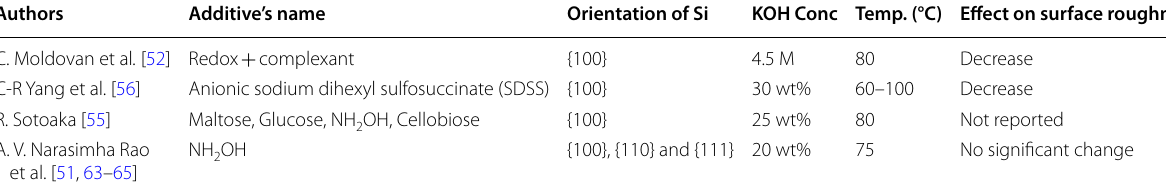
Table 5 The effect of various kinds of additives on the etched surface of silicon in KOH solution Authors